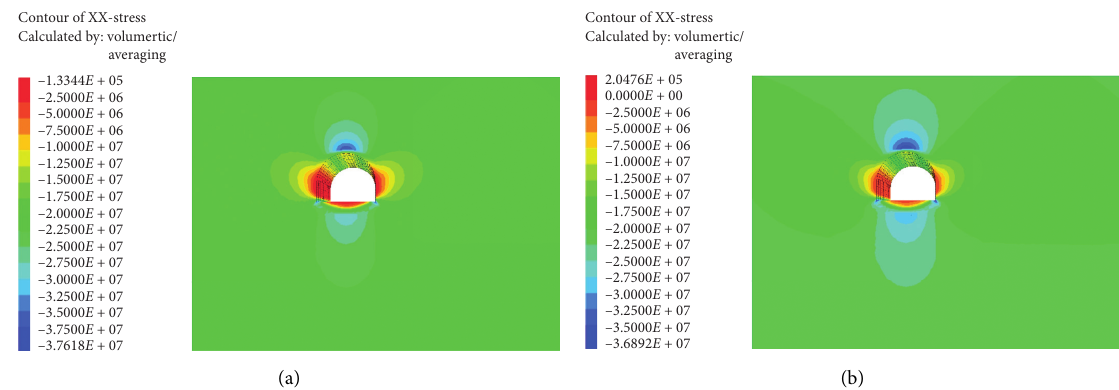
Figure 5: Horizontal stress of ahead roadway: (a) fully mechanized excavation and (b) blast excavation.